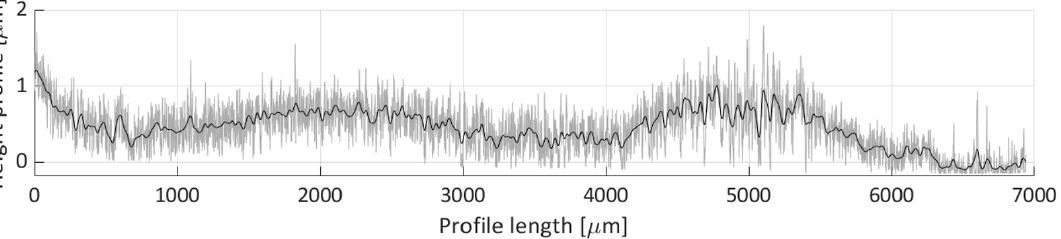
Figure 18. Definitions and naming convention for the performed profile scans on the deposited sample. Arrows indicate the scanning direction for the profile height lines shown in the following figures.